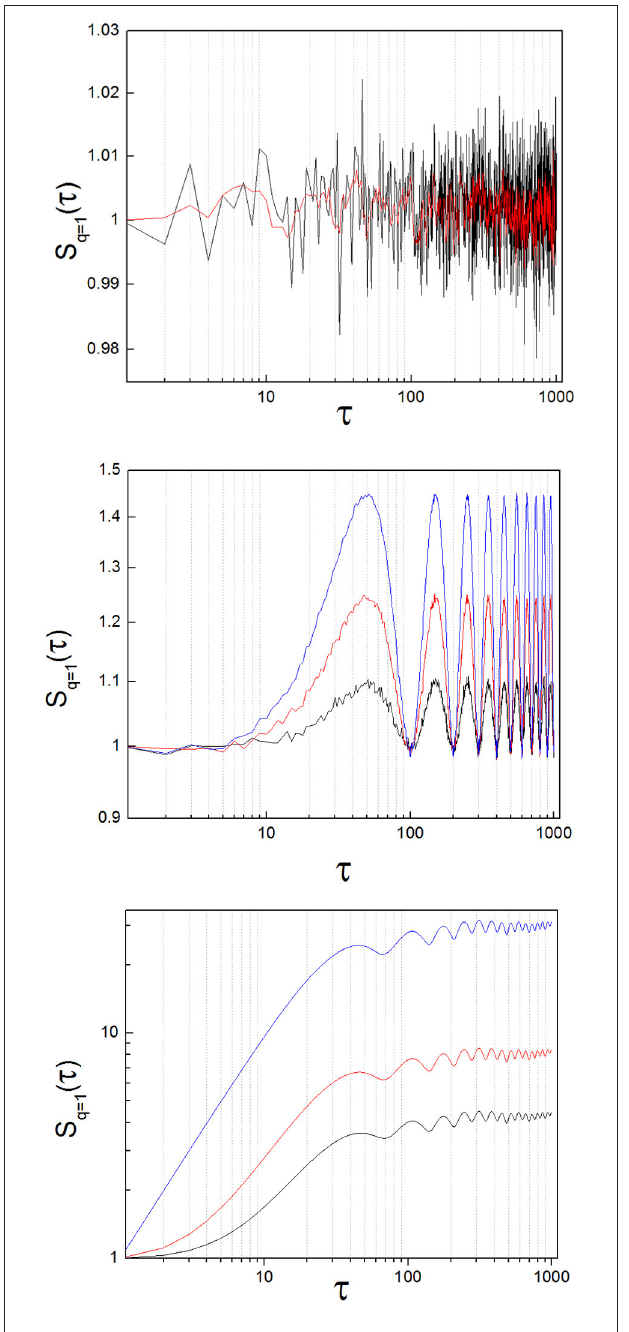
FIGURE 3 | Structure function of toy signals, with and without added noise. (Upper) Random signal, before (black) and after (red) applying a low-pass filter. The slope calculated with a linear regression lies around zero for both cases. (Middle) Oscillatory signal (sin(x)), with increasing levels of added noise, (blue: x1.0, red: x1.5, black: x2.0; see the text). The slope is zero on average, but the oscillations of the signal are clearly translated into the structure function. As added noise increases, the amplitude of the oscillations diminishes. (Lower) Lorenz system (x variable; parameters: σ = 10, ρ = 28, β = 8/3), with increasing levels of added noise, (blue: no noise, red: x1.0, black: x2.0; see the text). The breaking point lies around 40 < τ 1 < 110 for this example. Observe